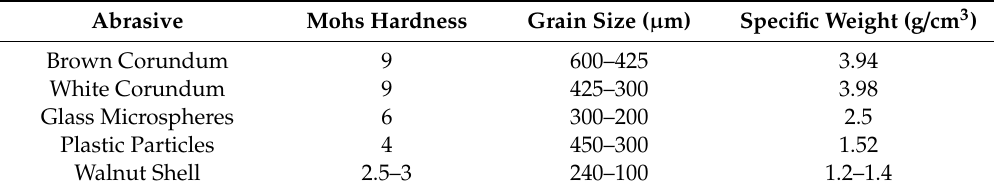
Table 3. Characteristics of the abrasives used in the study.